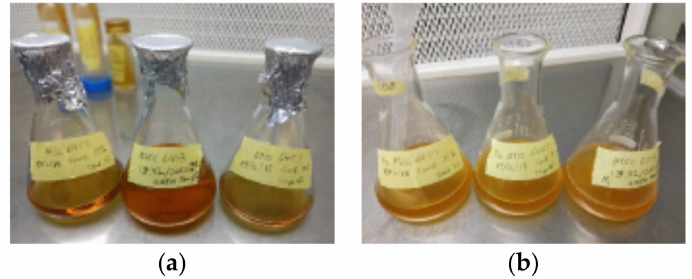
Figure 2. Bacterial broth ( a ) before culturing and ( b ) after 24–48 h in the